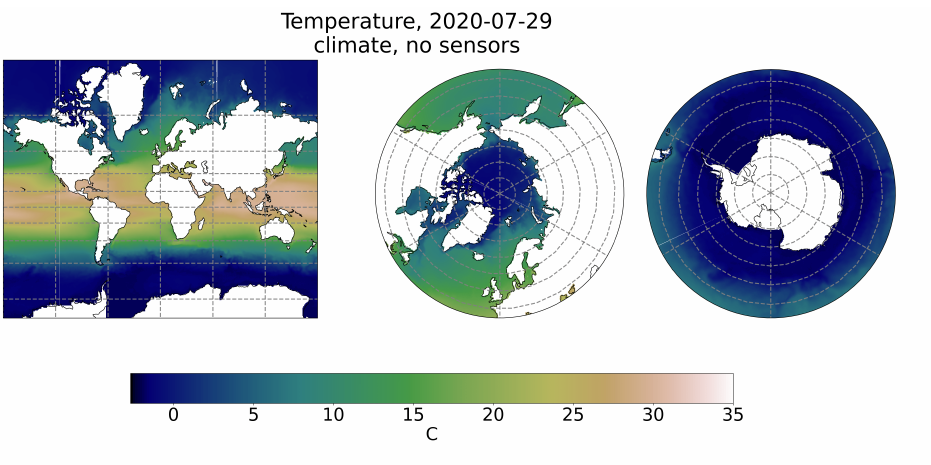
Figure 9. Reconstructed field from the climate without